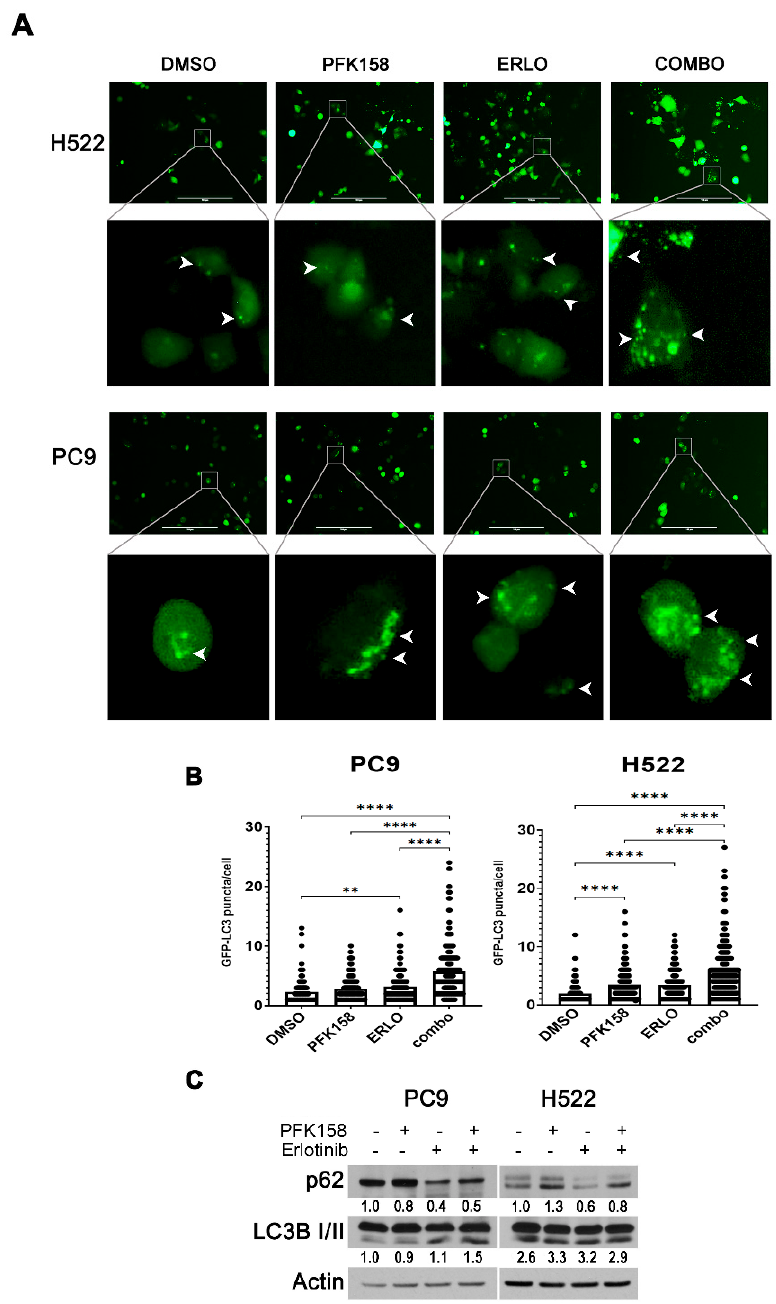
Figure 2. LC3-GFP overexpression reveals accumulation of autophagosomes in response to dual treatment in NSCLCs. PC9 and H522 cells were transfected with a pEGFP-LC3 plasmid and treated with erlotinib (PC9: 0.5 µ M; H522: 2 µ M) and/or PFK158 (PC9: 5 µ M; H522: 0.75 µ M) for 36 h or 24 h, respectively. ( A ) GFP-LC3 localization was evaluated by fluorescence microscopy. The formation of autophagosomes is depicted by the formation of puncta structures. Images were taken at 20 × magnification with an EVOS FL Imaging System microscope. Scale bar: 100 µ m. ( B ) Quantification of GFP-LC3 puncta/cell. The data presented are compiled counts of 180 cells/treatment regimen. Error bars, ± SD of two independent experiments. p values are shown as follows: ** < 0.01, **** < 0.0001 (compared to indicated treatment). ( C ) Whole cell lysates were immunoblotted with the indicated antibodies. Images shown are representative of two independent experiments. LC3 B II levels presented as normalized to actin and to the control treated cells (DMSO, PC9).